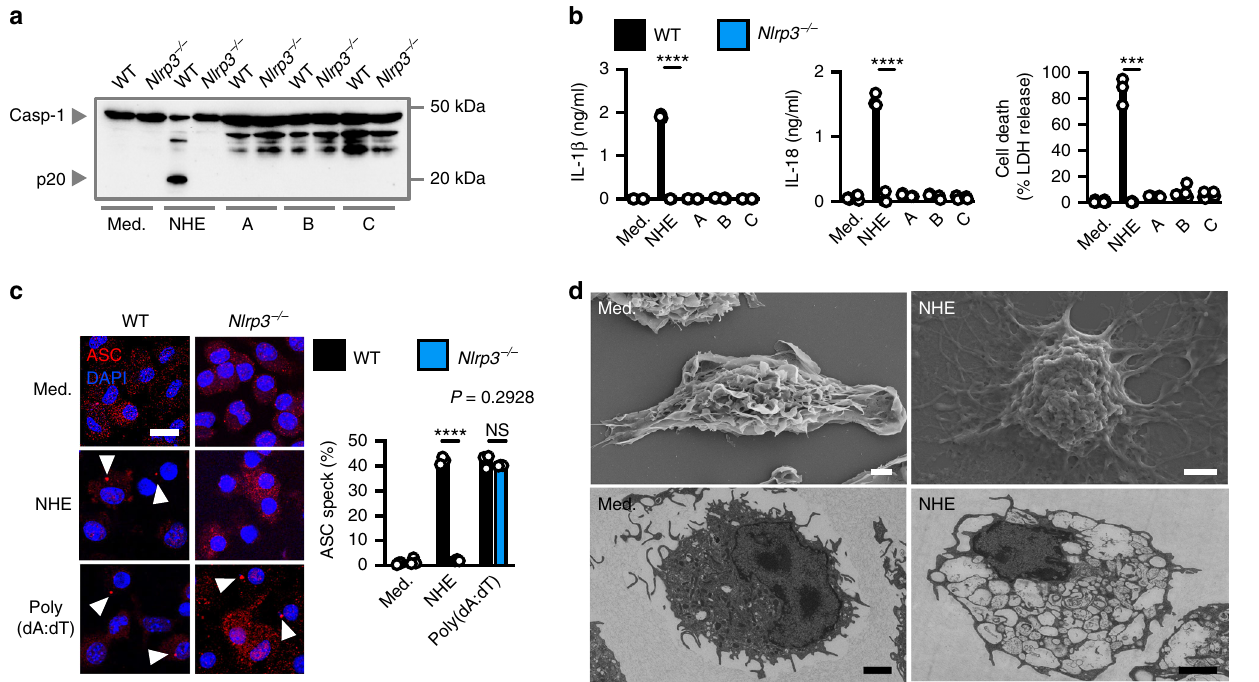
Fig. 4 NHE activates the NLRP3 in fl ammasome. a Immunoblot analysis of caspase-1 of WT or Nlrp3 − / − BMDMs left untreated (Med.) or LPS-primed and assessed 3 h after treatment with recombinant NHE, or with the individual NHE subunits; b release of IL-1 β and IL-18, and death of WT or Nlrp3 − / − BMDMs as treated in a . c , Immuno fl uorescent ASC speck analysis (red) in WT or Nlrp3 − / − BMDMs left untreated or LPS-primed and assessed 3 h after stimulation with NHE or 5 h after transfection with poly(dA:dT). Quanti fi cation of ASC specks as a percentage of total cells (DAPI). At least 200 cells from each genotype were assessed. Arrowheads indicate ASC specks. d Scanning electron microscopy analysis (top) or transmission electron microscopy analysis (bottom) of WT BMDMs left untreated or LPS-primed and assessed 3 h after treatment with NHE. Scale bar, 12 μ m c , 2 μ m d . NS, not signi fi cant, *** P < 0.001 and **** P < 0.0001 (student ’ s unpaired t test b and c ). Each symbol represents an independent experiment b and c . Data are representative of three independent experiments ( n = 3 in a – d ; mean and s.e.m. in b and c . Source data are provided as a Source Data fi